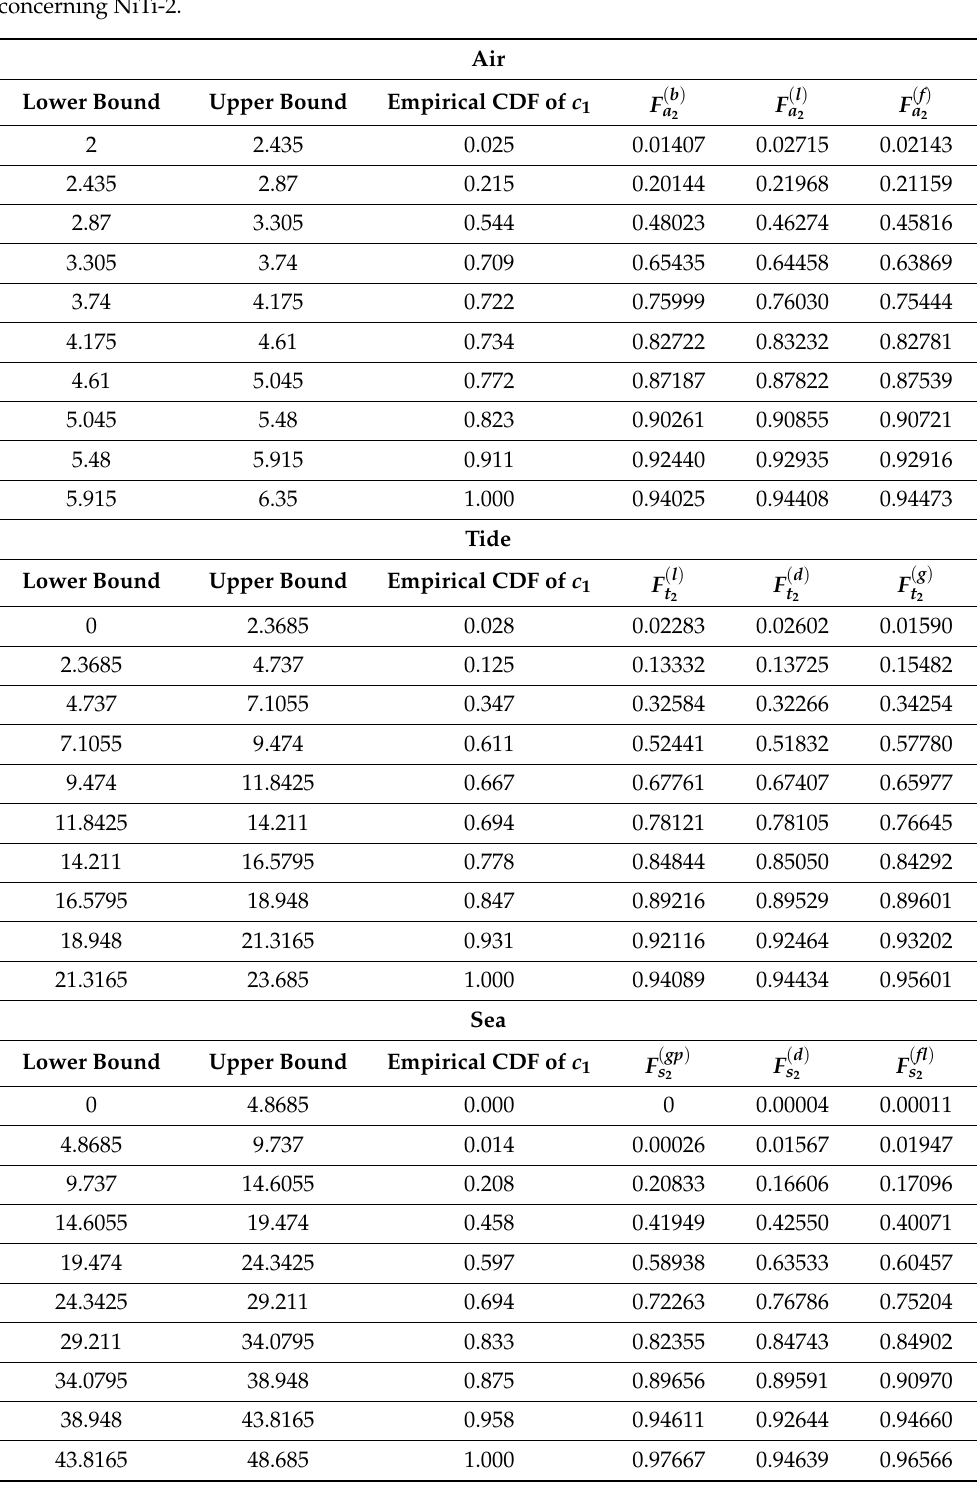
Table 14. The empirical values and the values of CDF for the three best-fitted distributions for c 1 concerning